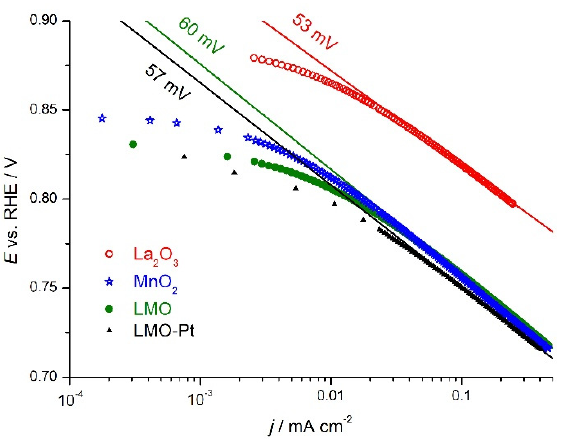
Figure 3. Ohmic-drop-compensated p о tentiod у n а mic Tafel с urv е s for the ORR at La 2 O 3 , MnO 2 , LMO, and LMO-Pt material in O 2 -saturated 0.10 M KOH, 25 °